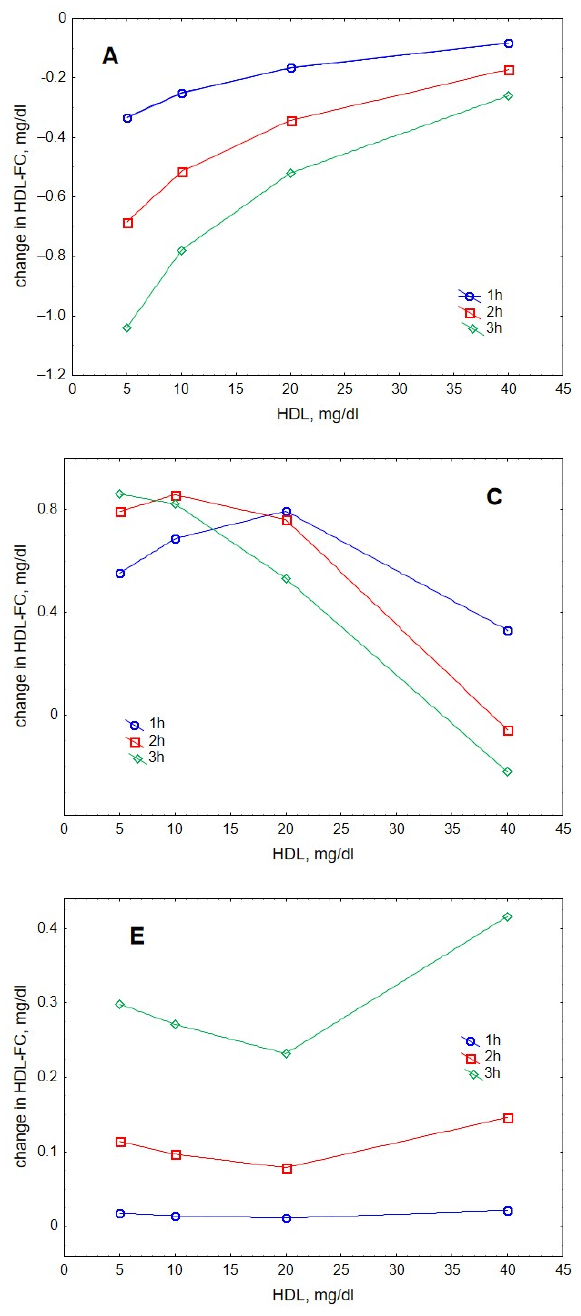
Figure 5. Dose-dependences of contributions to HDL-FC provided by individual processes , in- cluding LCAT-mediated formation of CE from FC in large, lipid-rich, spherical HDL ( A ), LCAT- mediated formation of CE from FC in small, lipid-poor, discoidal HDL ( B ), FC transfer from VLDL to HDL under the action of FC concentration gradient ( C ), FC transfer to HDL upon collisions between VLDL and HDL particles ( D ) and FC transfer to HDL upon fusion of lipid-poor apoA-I with lipid-rich HDL ( E ). Mathematical modelling was performed under conditions of in vitro TGRL lipolysis described elsewhere [25] for the reaction time of 1 (blue circles), 2 (red squares) and 3 (green diamonds) h. In order to calculate accumulation of FC in HDL, its content at baseline (t = 0) was subtracted from the results of the modelling. Initial concentrations: VLDL-TG, 30 mg/dl; LPL, 190 U/mL. Further comparison of the roles of the individual processes at different HDL concentra- tions showed that both at early reaction times (Figure 6A–D) and low HDL